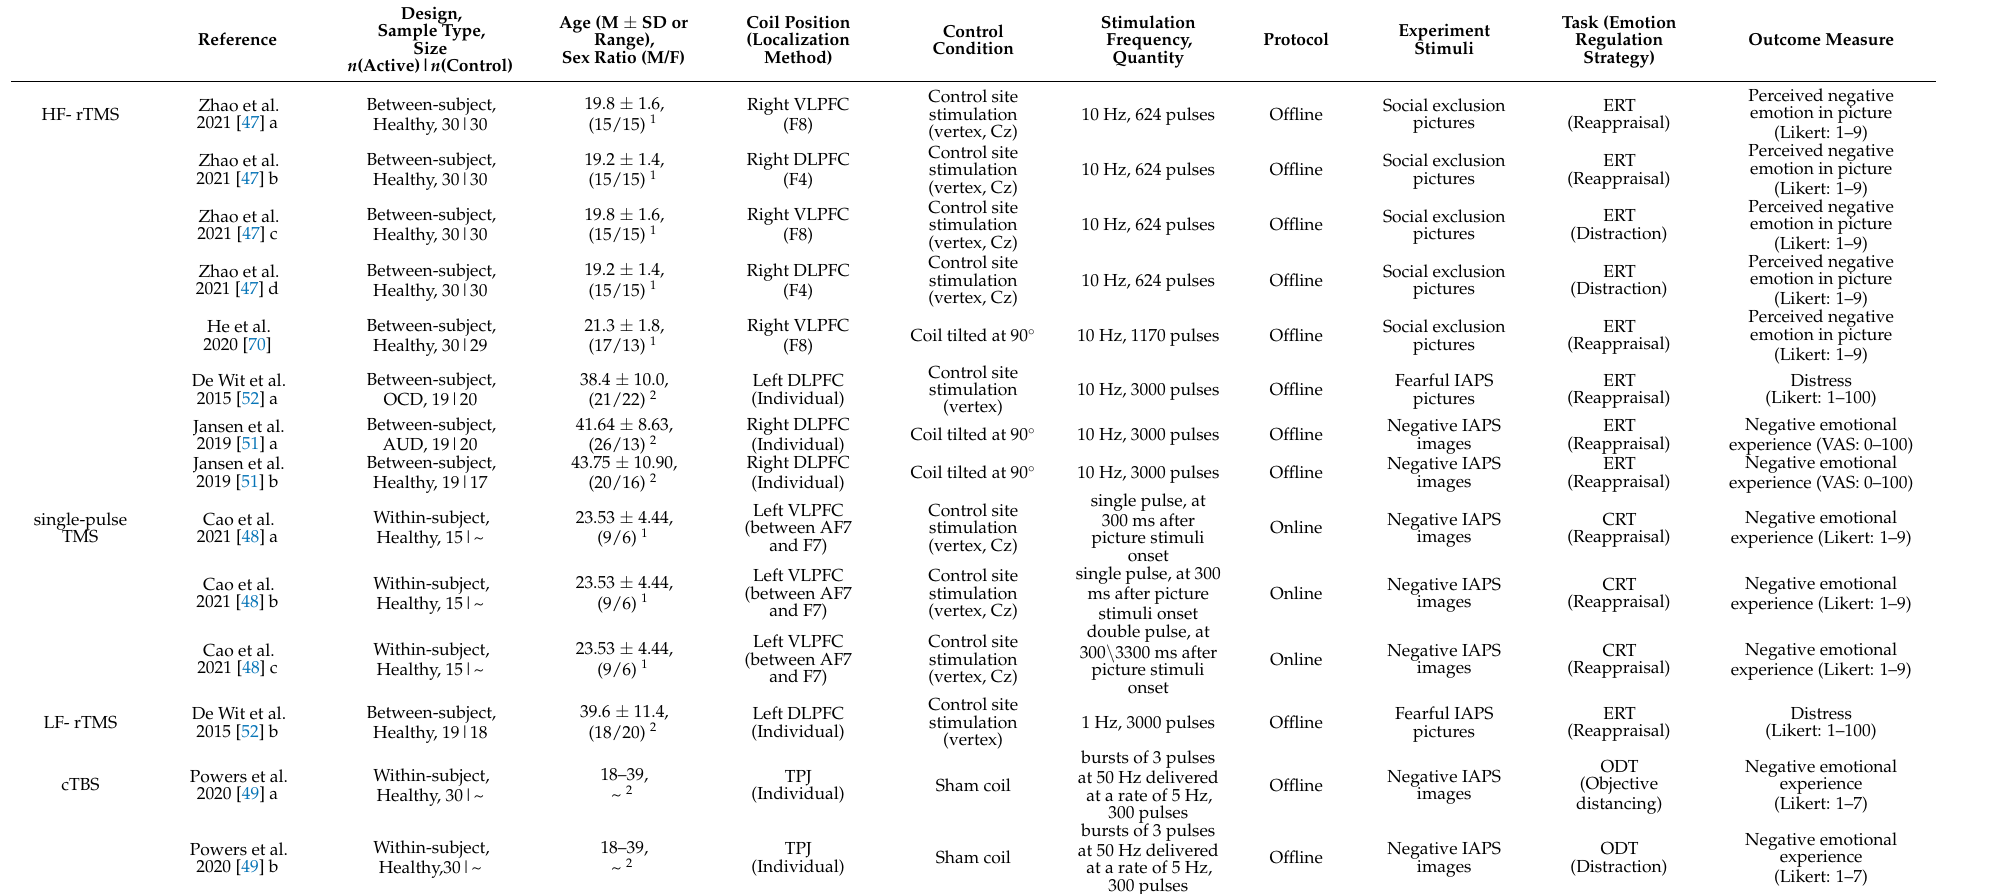
Table 1. Characteristics of included transcranial magnetic stimulation